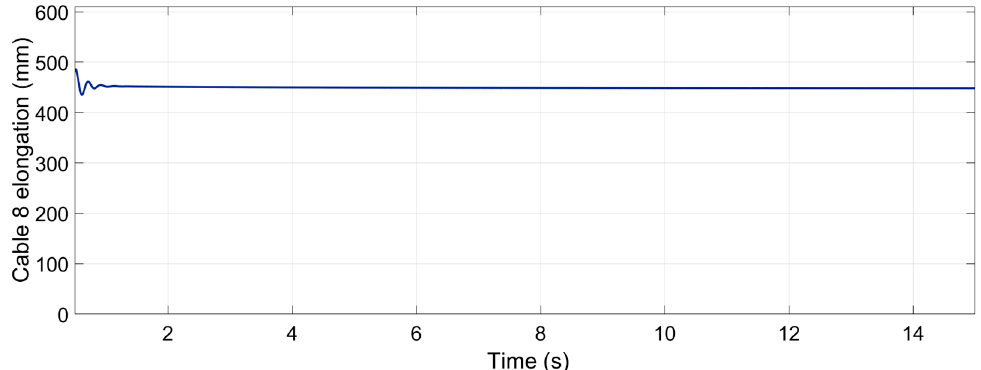
Figure 20. Elongation of the spring situated between cable 8 and the end-effector. The value oscillates between 0.451 and 0.448 m after the stabilization of the measure.